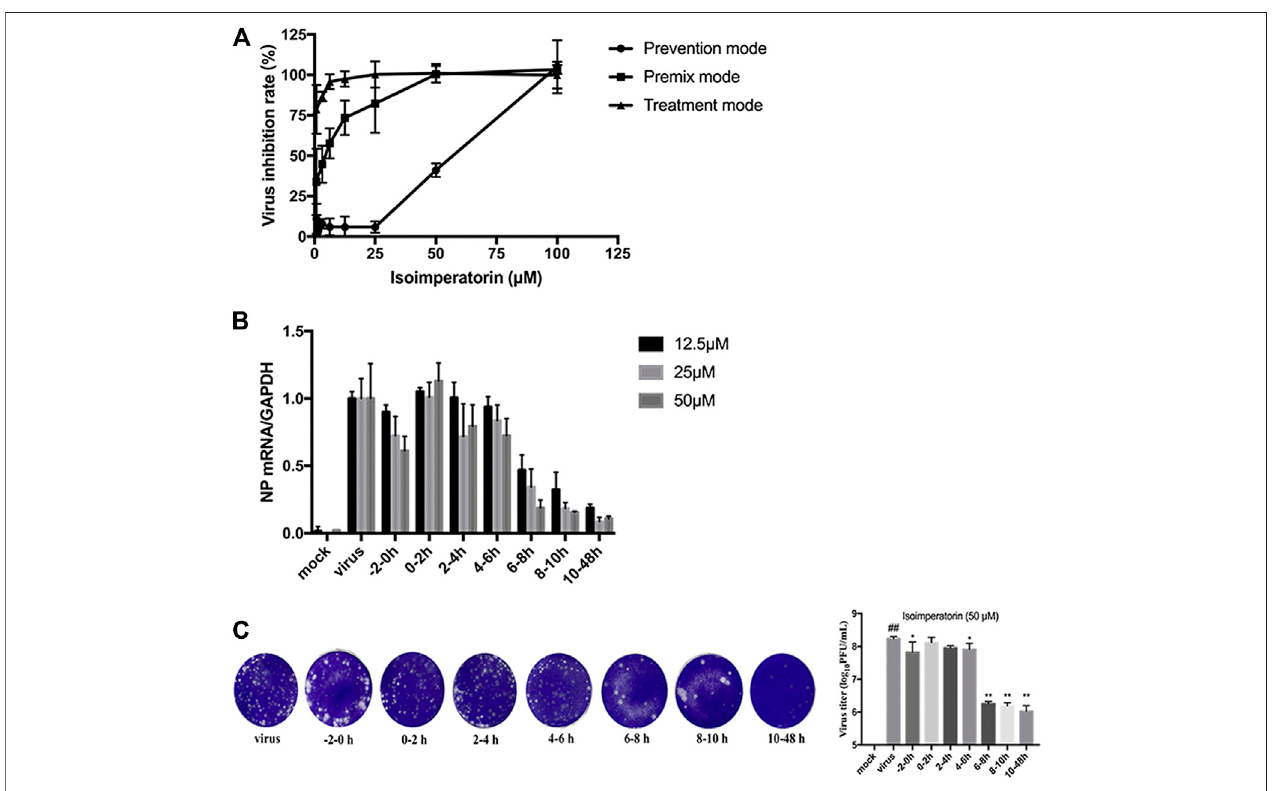
FIGURE4| Inhibitoryeffectofisoimperatorinonthespeci fi cstepsoftheviruslifecycle. (A) Differentmodesofmedication.Theinhibitoryeffectsofisoimperatorinon H1N1 A/PR/8/34 virus in three medications were detected by CCK-8 assay at 48 h postinfection. (B,C) Isoimperatorin inhibits in fl uenza A virus replication at the late stage of the viral lifecycle. Cells were inoculated with 100 μ l of 100 TCID 50 virus. Isoimperatorin was added within the set time, and then the cells were incubated with freshmedium until48 hafterinfection. TheNPmRNAlevelwasdeterminedbyRT-PCR (B) ,andthevirustitreinthesupernatantwasdetectedbyplaquereduction assay (C) . Data are representative of three independent experiments (mean ± SEM). Statistical signi fi cance was analysed by one-way ANOVA. # p < 0.05, ## p < 0.01, relative to the mock control group. *p < 0.05, **p < 0.01, relative to the virus group.